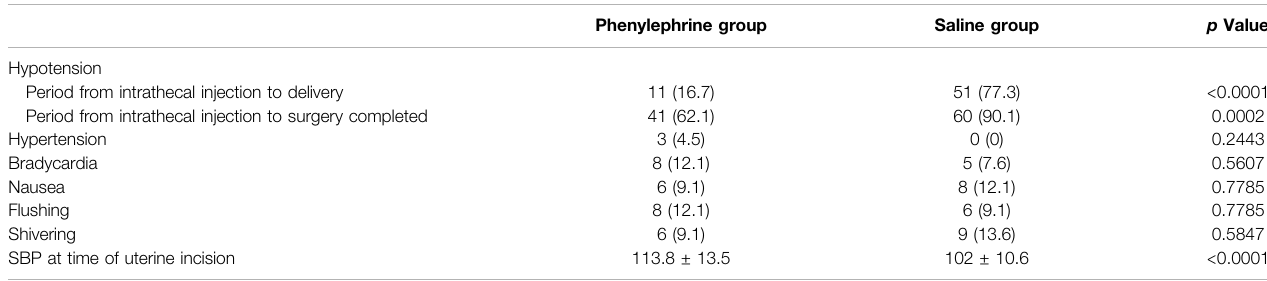
TABLE 3 | Comparison of side effects and SBP at time of uterine incision between two groups during CD. Phenylephrine group Saline group p